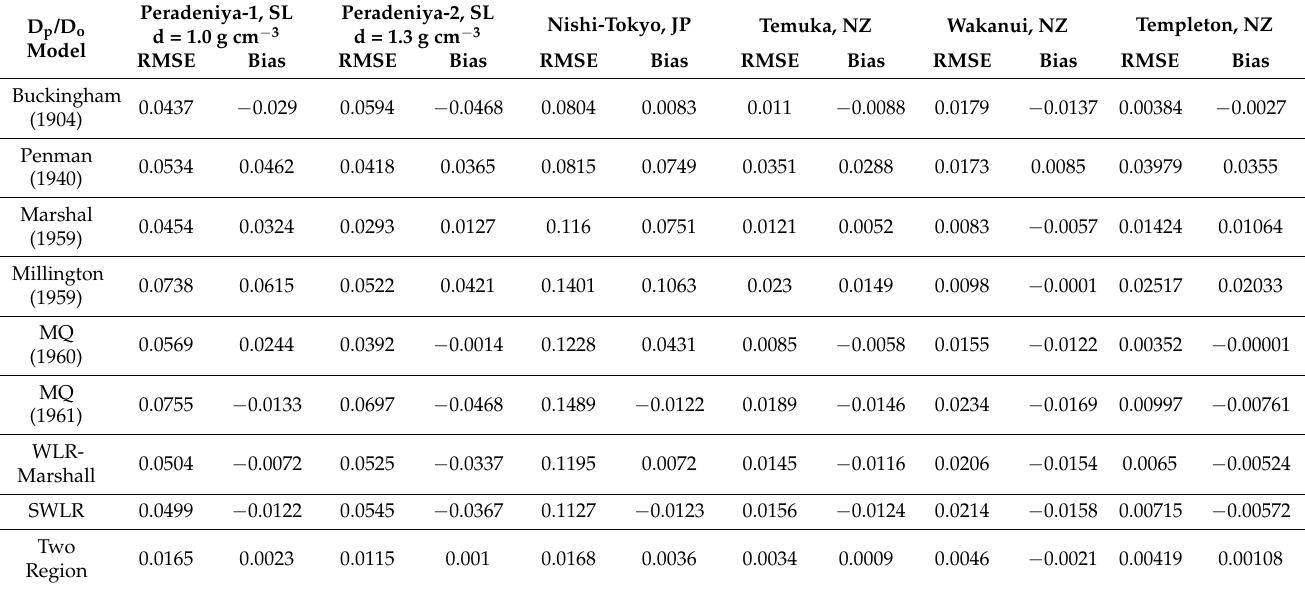
Table 3. Statistical analysis on model performance using RMSE (Equation (9)) and Bias (Equation (10)) for intact soils.